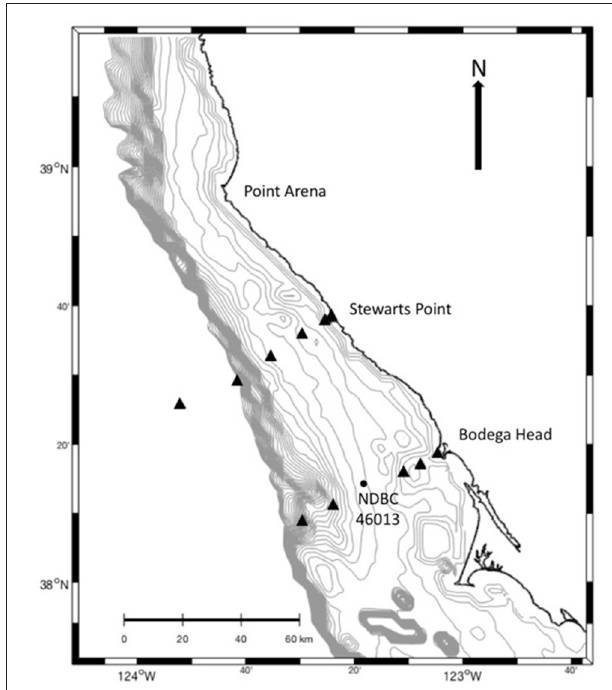
FIGURE 1 | Map of the study area depicting locations of stations along cross-shelf transects off Bodega Head and Stewarts Point in northern California. Location of NDBC buoy 46013 ( • ) is also shown.